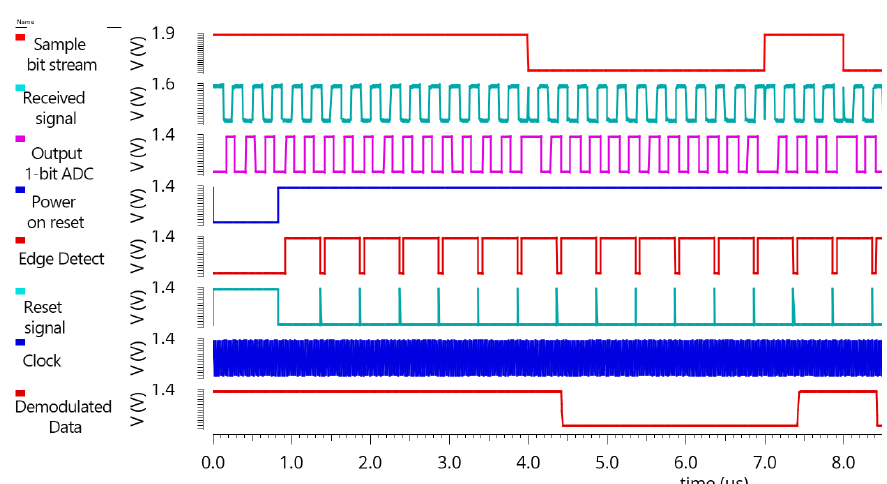
Figure 17. Simulated waveforms and timing diagram of the BPSK receiver.